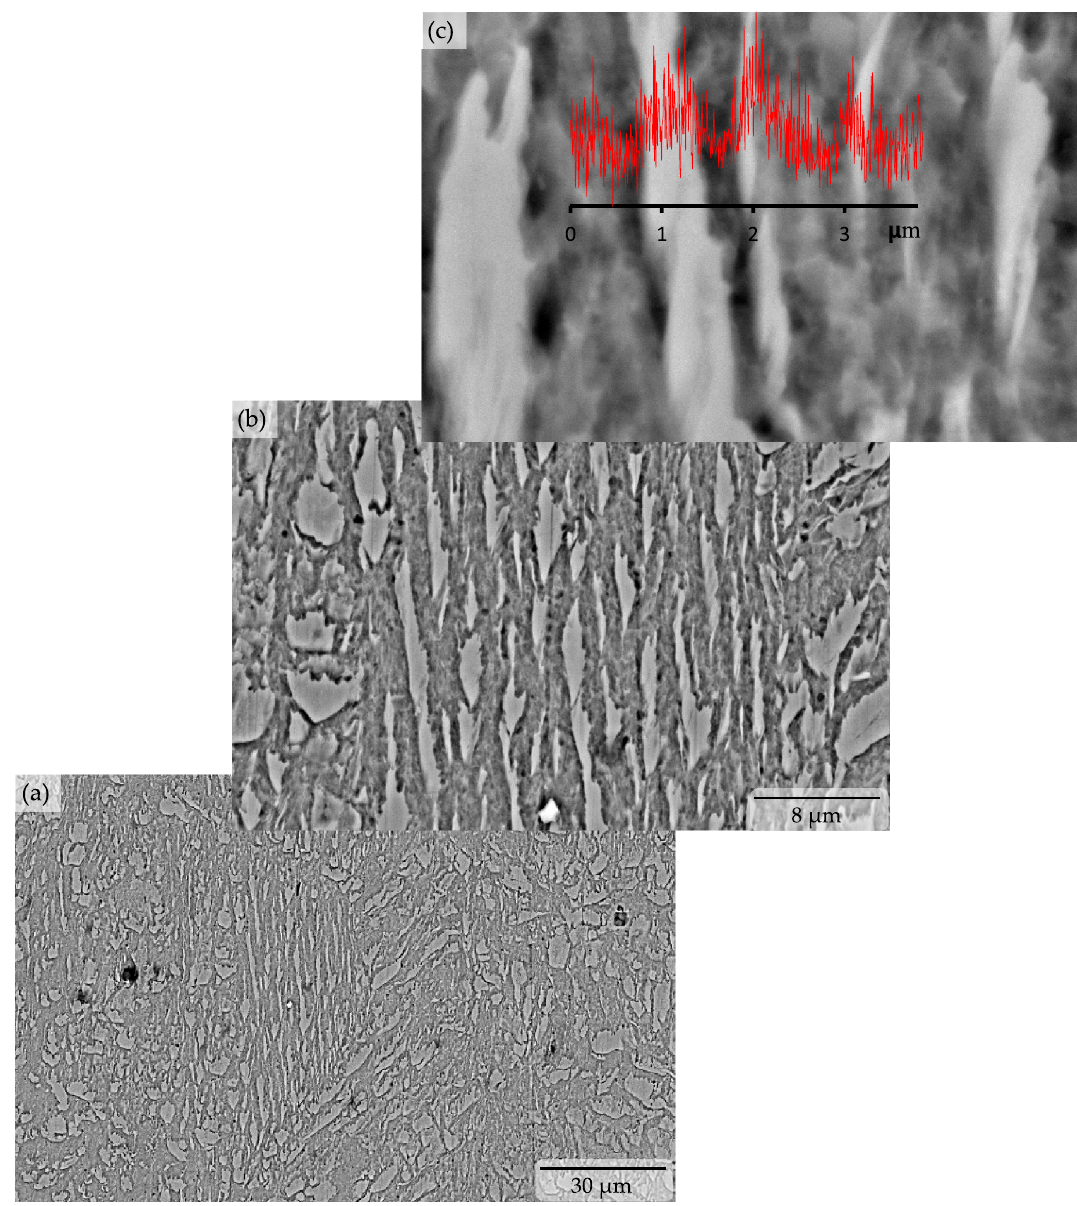
Figure 3. Backscattered electron image showing bainitic ferrite sheaves with retained austenite and/or martensite/austenite constituent due to quench and partitioning heat treatment in different magnification, with carbon concentration profile along the